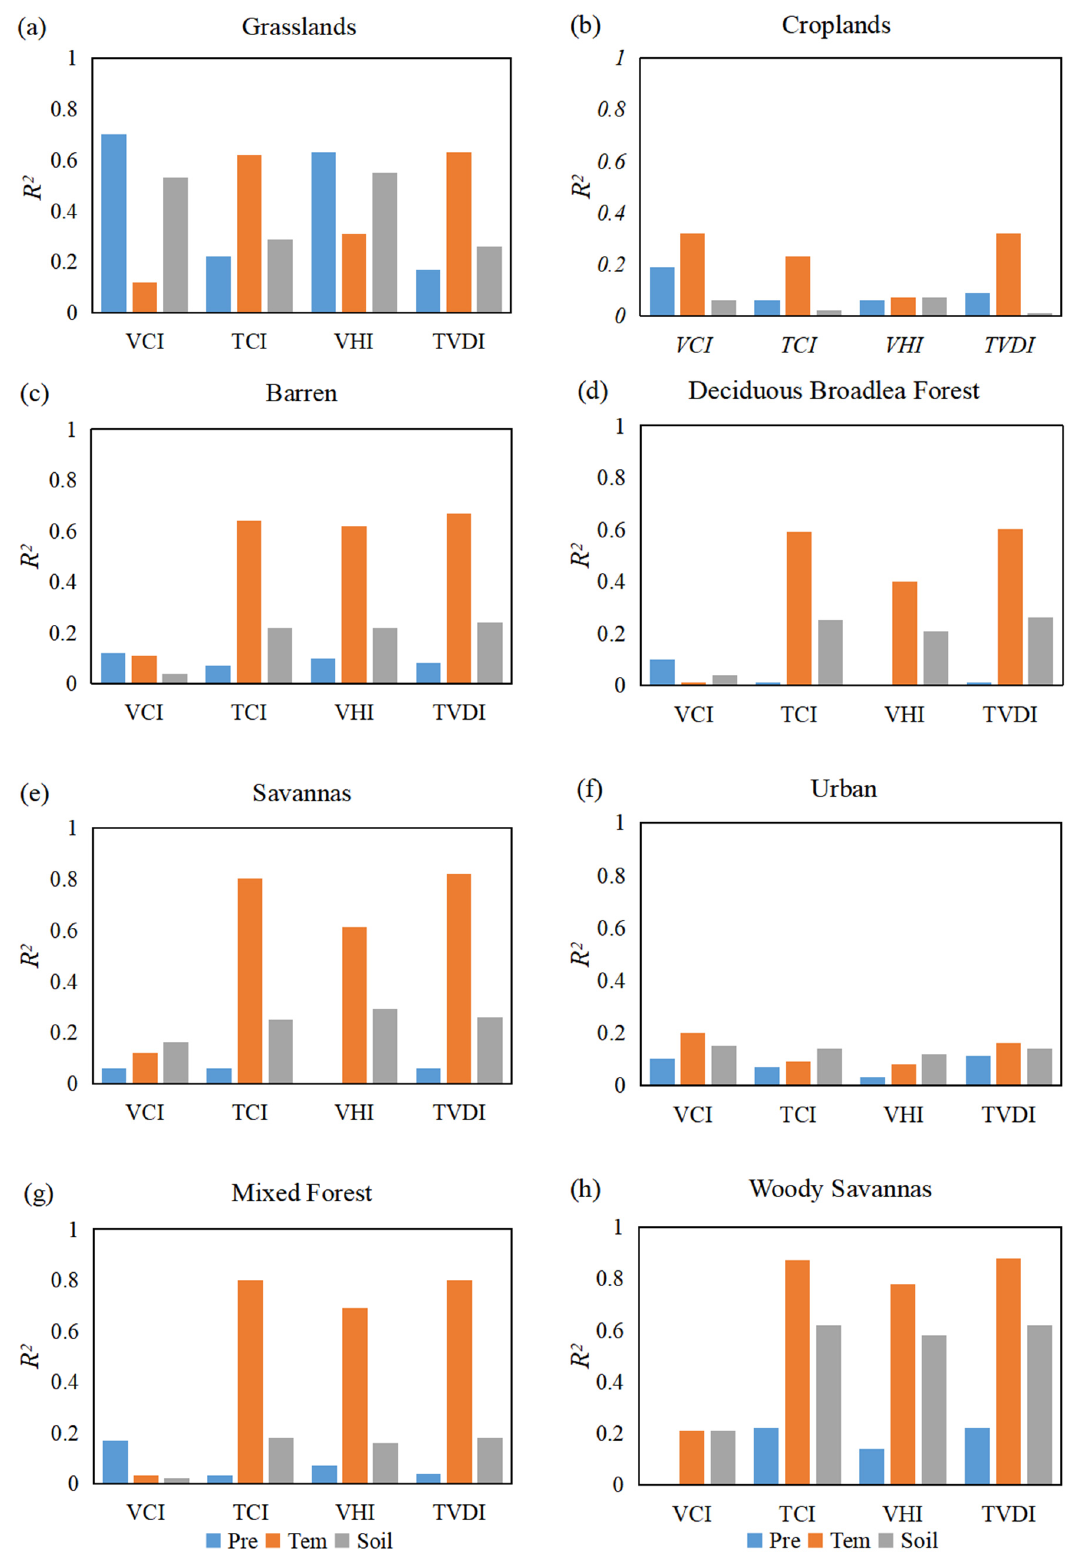
Figure 5. Correlation of the drought index with precipitation, air temperature, and soil moisture. ( a ) Grasslands; ( b ) croplands; ( c ) barren; ( d ) deciduous broadleaf forest; ( e ) savannas; ( f ) urban; ( g ) mixed forest; ( h ) woody savannas. According to Figure 5, in the grasslands area, VCI, VHI has a significant correlation with precipitation and soil moisture (R 2 > 0.5), and TCI, TVDI has a significant correlation with the air temperature (R 2 > 0.6), indicating that drought in grasslands is affected by precipitation, temperature, and soil moisture. In croplands and urban lands, there is weak correlation with precipitation, temperature, and soil moisture due to human activity (R 2 < 0.3). In barren lands, deciduous broadleaf forests, savannas, and mixed forests, drought is mainly affected by temperature, and drought indexes of TCI, VHI, and TVDI are strongly related with temperature (R 2 > 0.4), while VCI is weakly correlated with temperature (R 2 < 0.1). In woody savannas, TCI, VHI, and TVDI are more associated with temperature and soil moisture than in other regions, and the drought conditions are more affected by temperature and soil moisture.